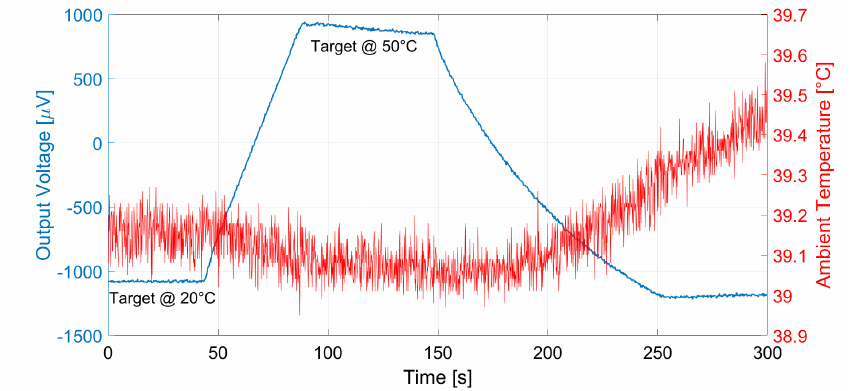
Figure 14. Measured thermopile E2 output with the black body at 10 cm distance and ambient temperature equal to 40 ◦ C. The black body temperature was varied as a ramp from 20 to 50 ◦ C. The thermopile detector sensitivity was measured for each considered case, both for E1 and E2,